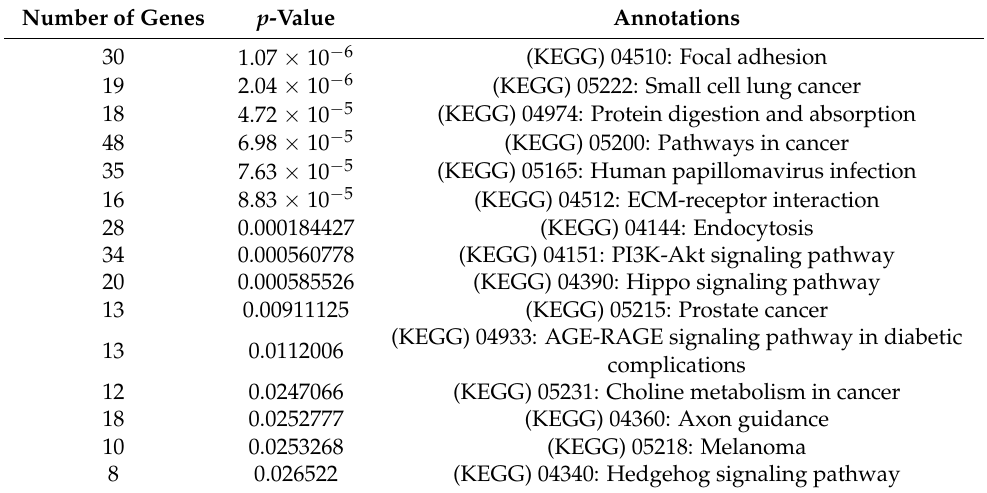
Table 1. Significantly enriched pathways regulated by the miR-29-3p- family in ICC cells.